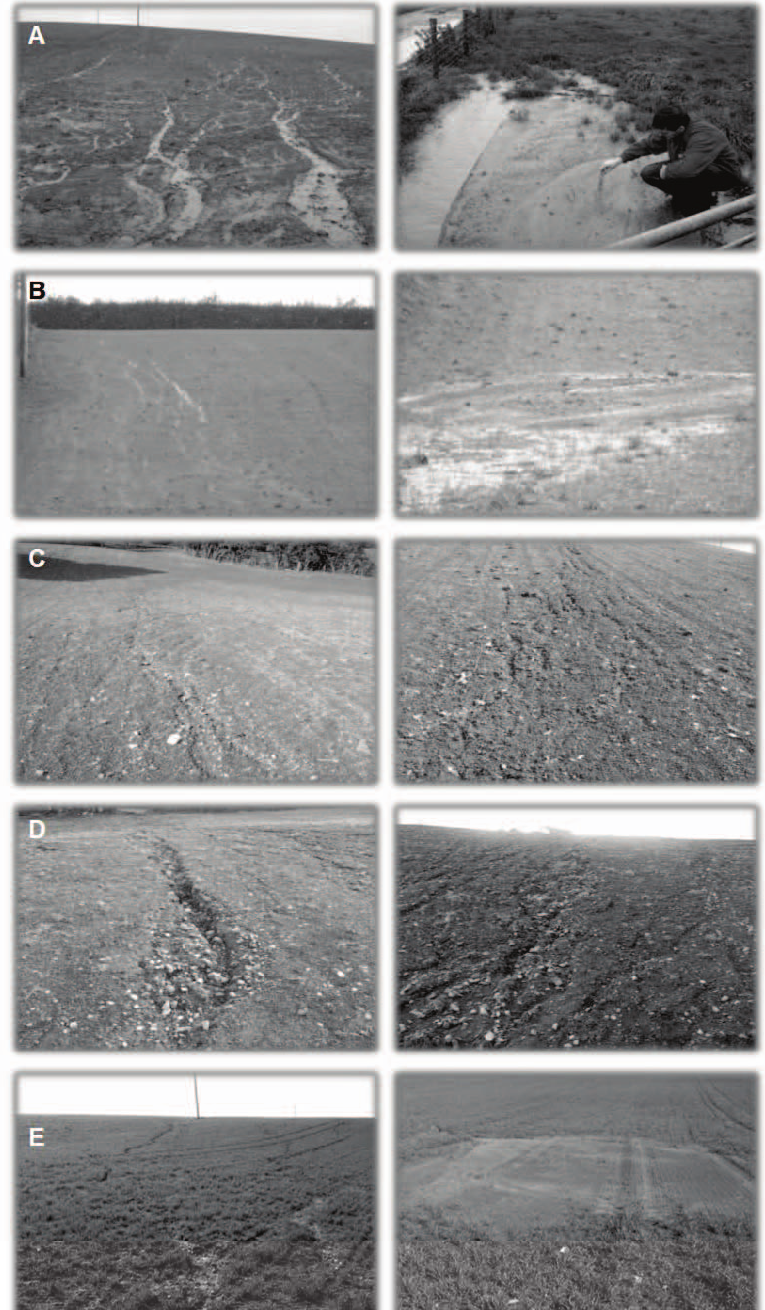
Figure 1. Five separate soil erosion events on agricultural land in County Tyrone between 2008 and 2012. ( A ) Loughmuck, Omagh, Co. Tyrone; ( B ) Ballynahatty, Omagh, Co. Tyrone; ( C ) Kevlin, Omagh, Co. Tyrone; ( D ) Aughafad, Clogher Valley, Co. Tyrone; ( E ) Blackfort, Omagh, Co.